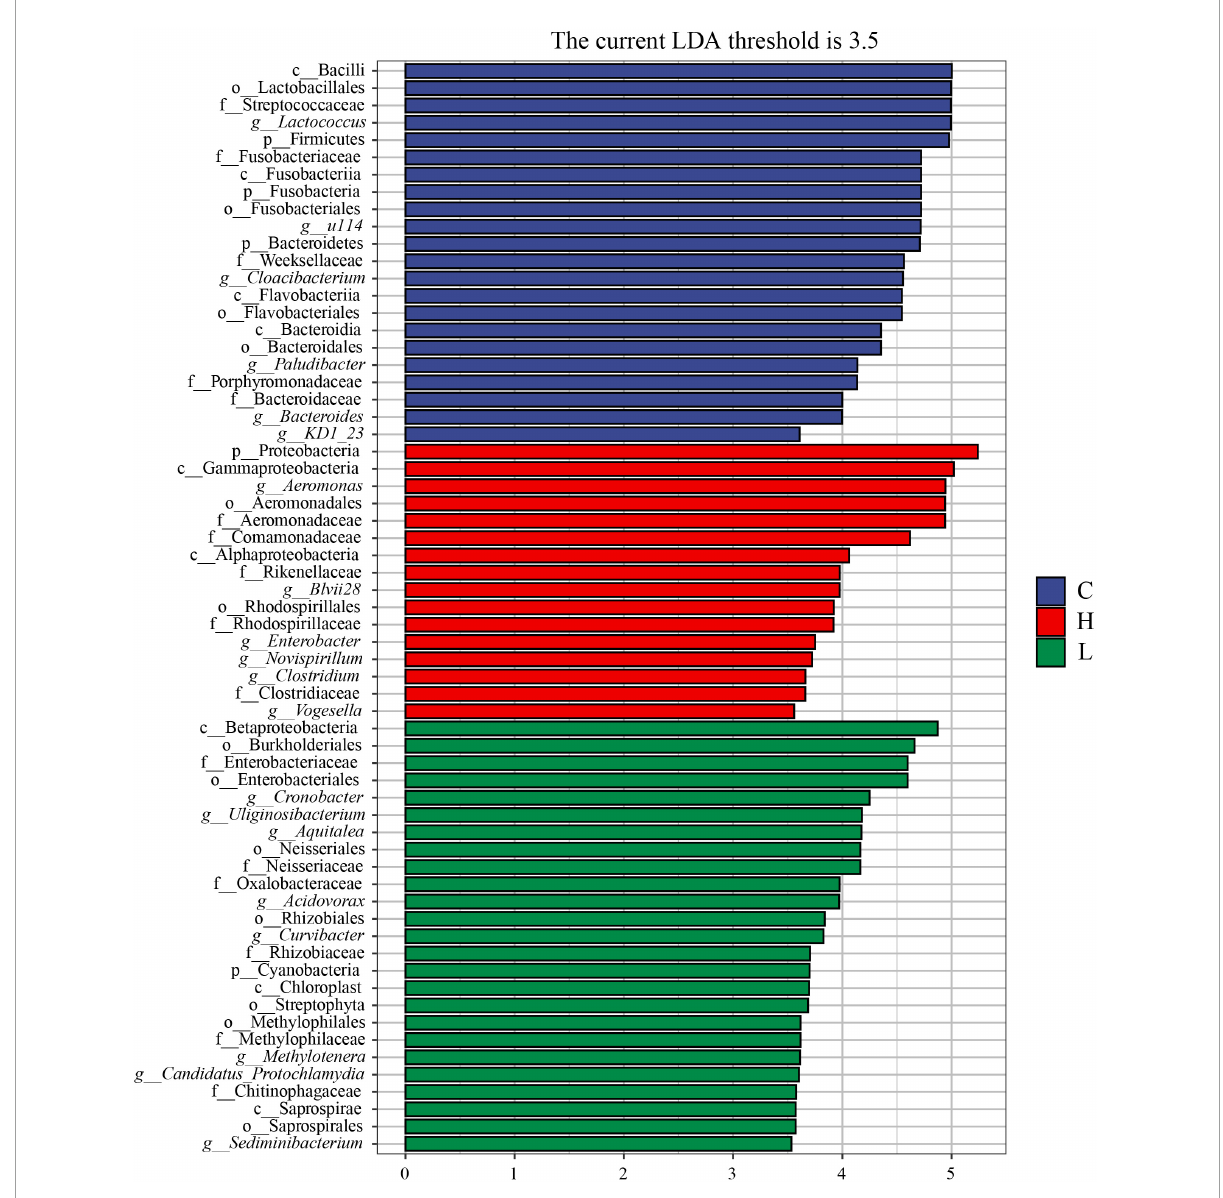
FIGURE8 LEfSe analysis of Pomacea canaliculata intestinal microbiota composition under different temperature. The c, g, f, o, and p represented class, genus, family, order, phylum,